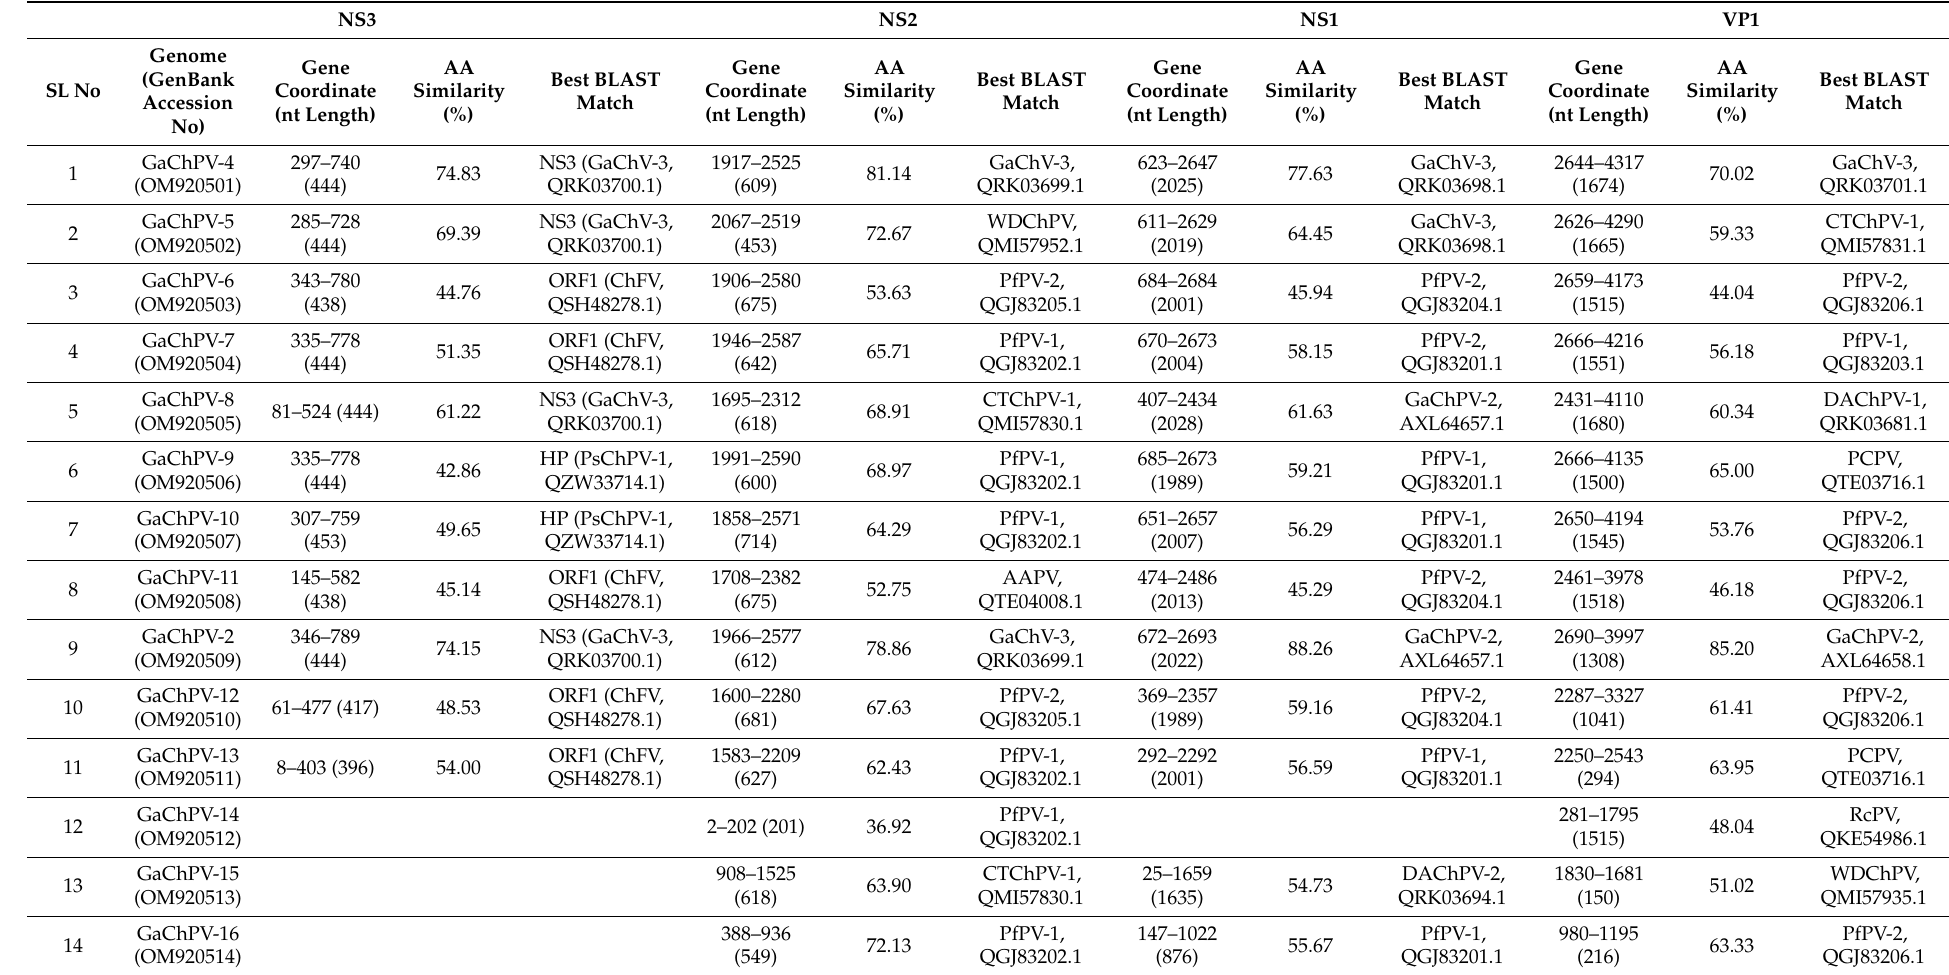
Table 2. Comparative analysis of ORFs of galliform chaphamaparvovirus (GaChV) detected in this